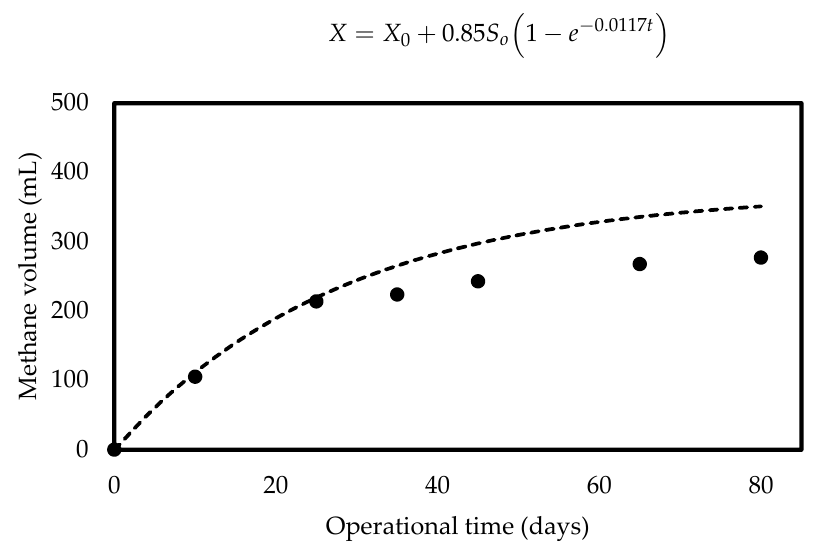
Figure 2. Time profile of the methane volume released during anaerobic sludge and RPME effluent degradation under mesophilic conditions (35 ± 2 °C). Symbols refer to the experimental data and dash lines to the model predictions with k = 0.0356 ± 0.004 day − 1 and α S o = 327.9 ± 21 mL.